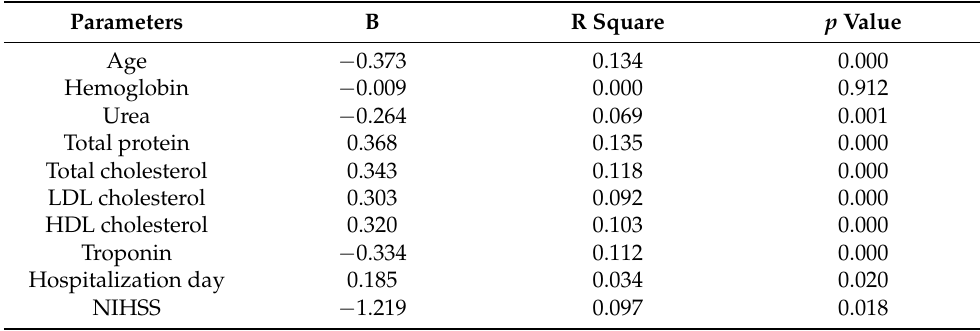
Table 4. Linear regression analysis between PNI and clinical parameters in patients with acute ischemic